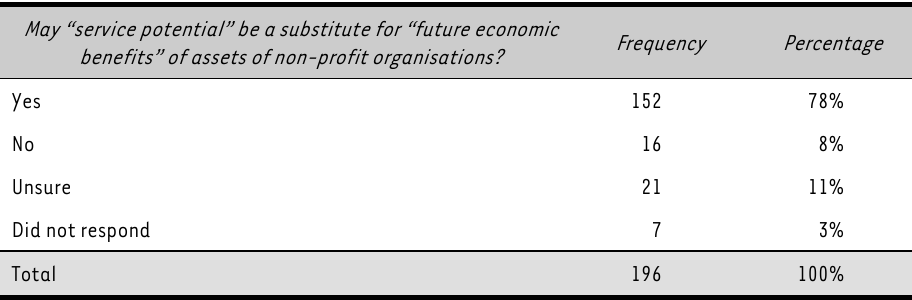
Service potential of